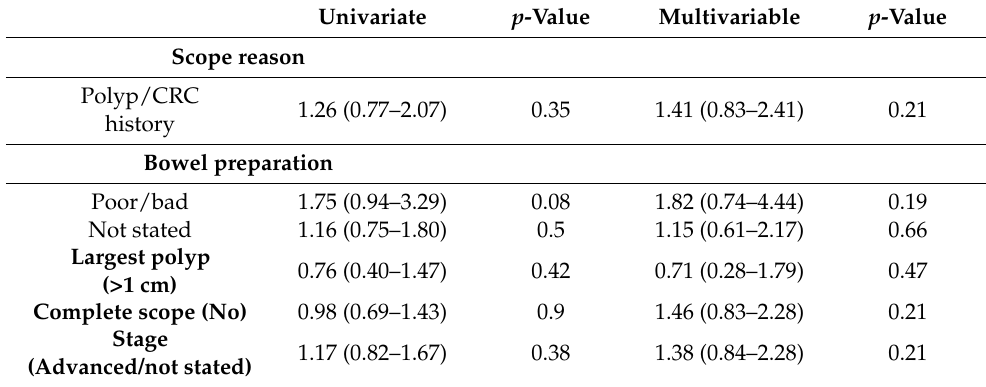
Table 3. Derived univariate and multivariable odds ratios for a right sided